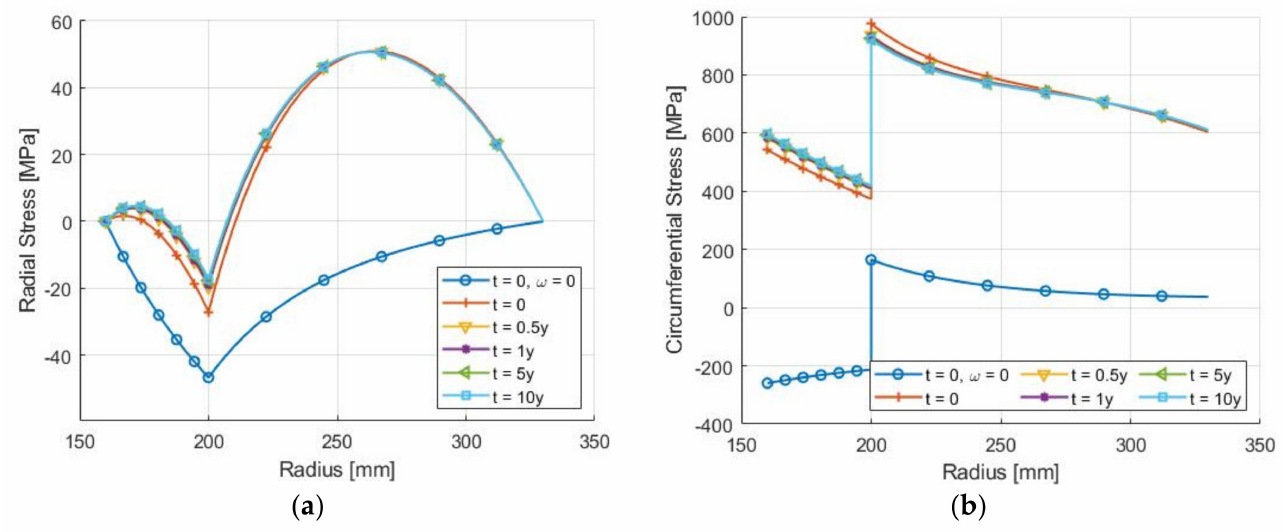
Figure 5. Evolution of ( a ) radial and ( b ) circumferential stresses at different times of operation (0–10 years) of a flywheel rotor with an aluminum hub and carbon FRP composite rim due to viscoelastic stress relaxation